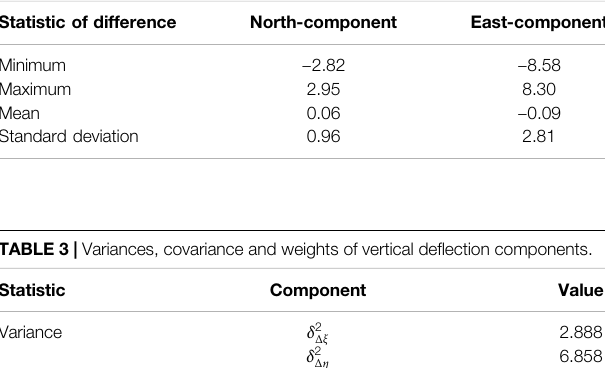
TABLE 2 | Summary statistics of vertical de fl ection components compared with EGM2008-simulated components (unit: arcsecond). Statistic of difference